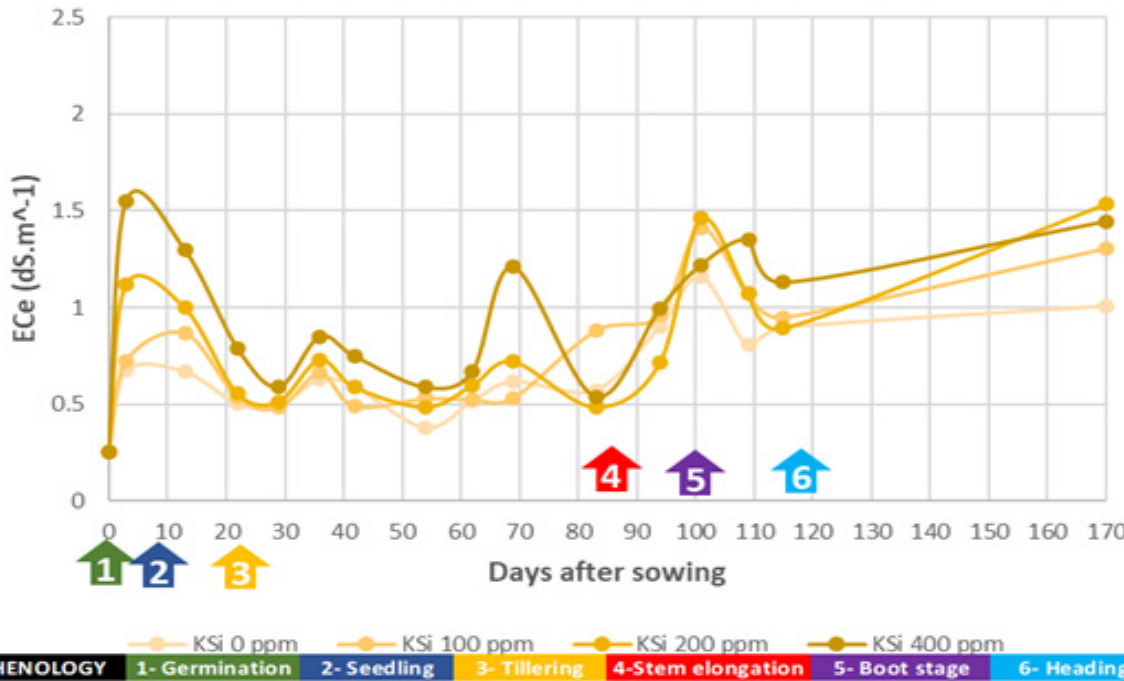
Figure 3 . Fluctuation of ECe ( dS.m - 1 ) for all potassium silicate treatments (KSi Xppm) during the field stage of the